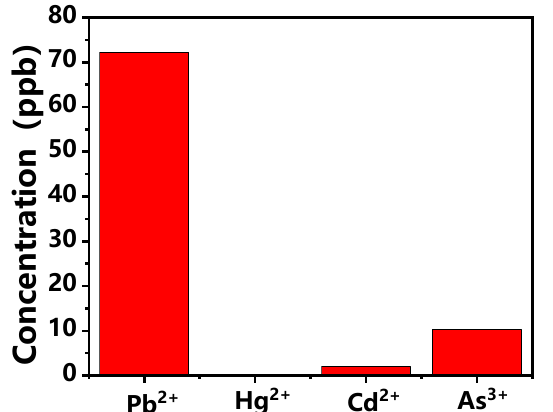
Figure 6. Evaluation results for four heavy metal ions in shrub branches and leaves.